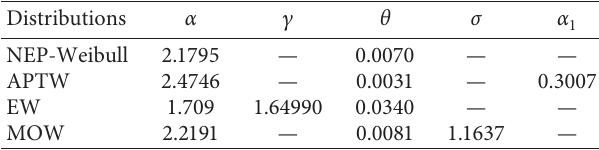
Figure 7: The histogram, TTT transform, and box plots of the life span of the WSNs data. Table 1: The summary measures of the life span of the WSNs data. Table 2: The MLEs of the fitted models to the life span of the WSNs data. Min. 1st qu.